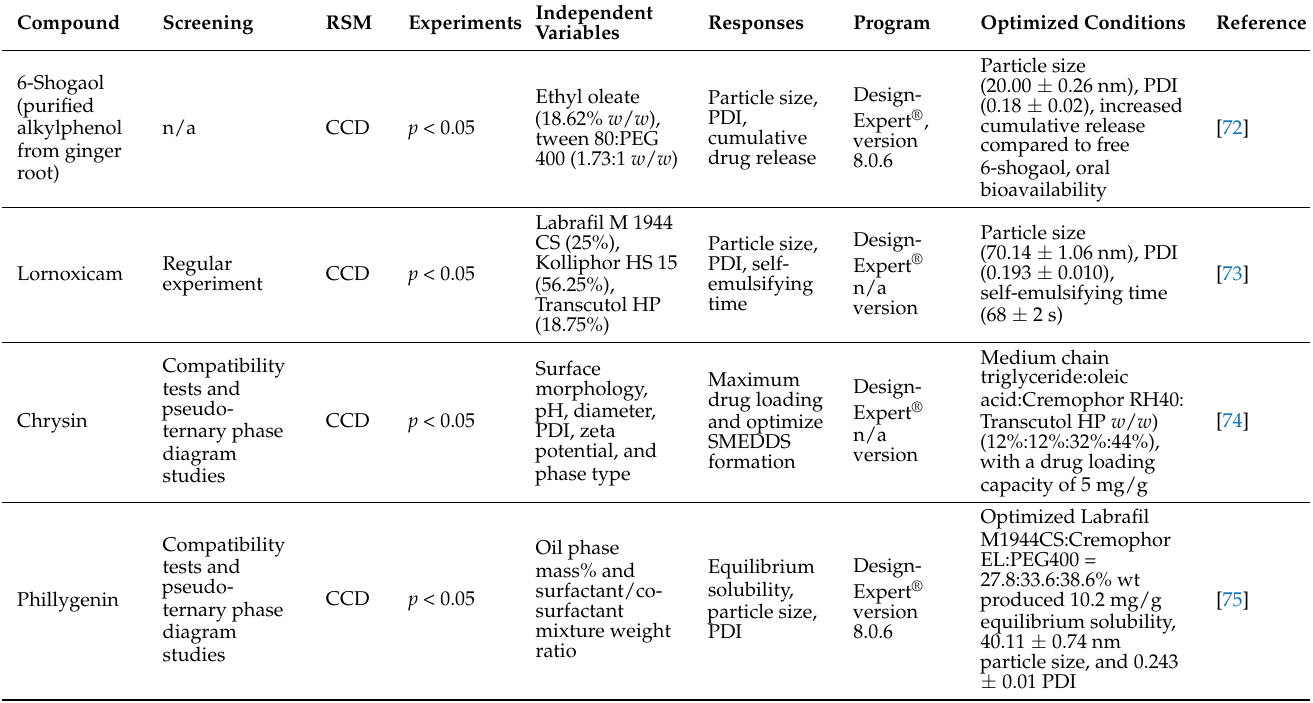
Table 5. List of the SMEDDS developments along with the applied response surface methodology (RSM) of central composite design